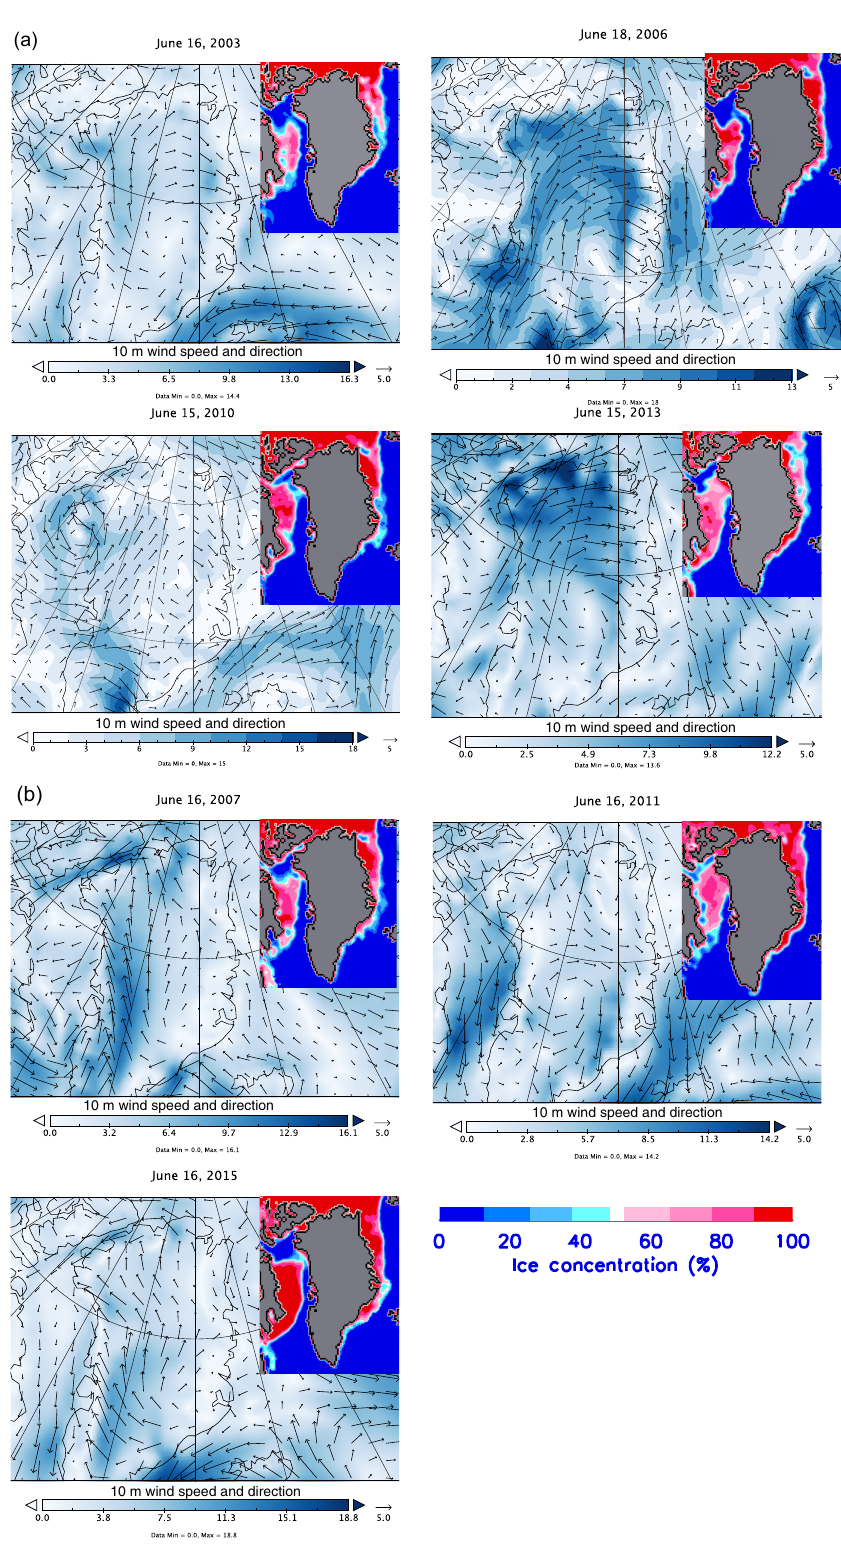
Figure 12. Wind vectors and speeds at 10m from MERRA-2 during 4 early sea melt years over Baffin Bay ( a ) and 3 late sea melt years ( b ). Smaller figures superimposed on the wind maps show the sea ice concentration (%) for that